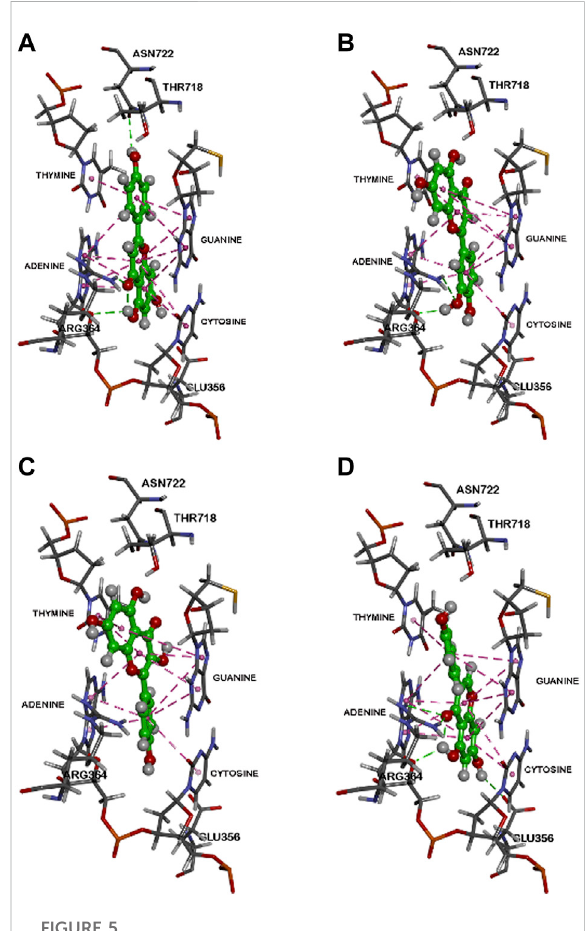
FIGURE 5 Binding modes of fl avonoids within the human Top 1-DNA complex. The binding modes within the human Topo1-DNA complex (pdb id: 1K4T) are shown for, (A) apigenin, (B) luteolin, (C) kaempferol, and (D) genistein. Polar and non-polar interactions are colored coded and details are provided in text.